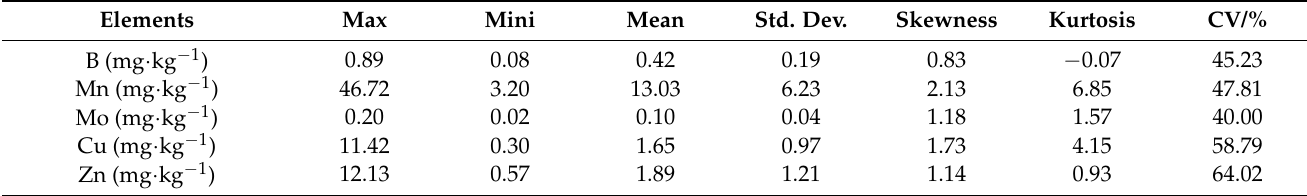
Table 1. Descriptive statistics of soil trace elements.